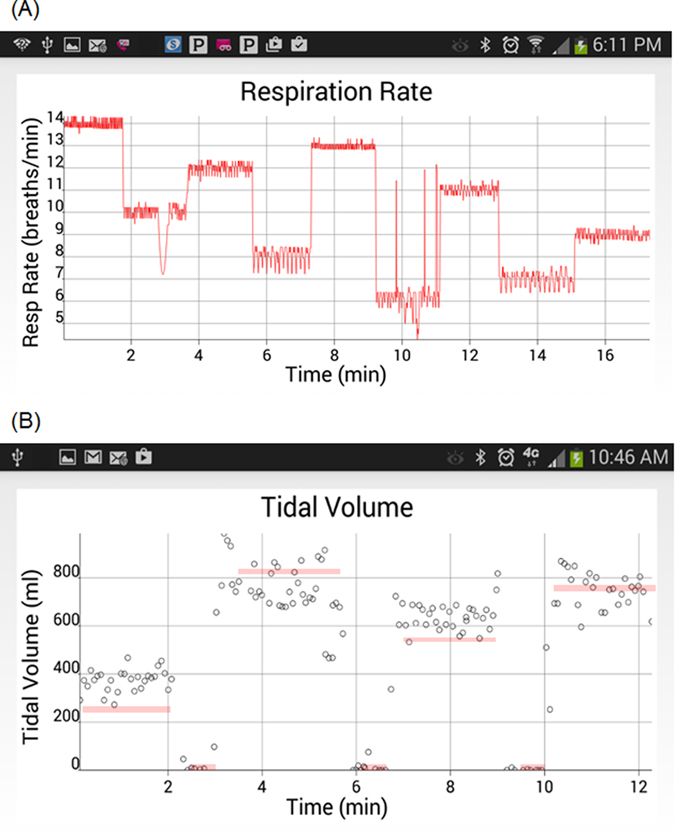
Estimation of the respiration rate (RR) and tidal volume (TV).Different RRs and TVs were obtained by adjusting the mechanical ventilator and using the reading in its display as the gold-standard. (A) The respiration rate was randomly changed from 14 to 10 to 12 to 8 to 13 to 6 to 11 to 7 to 9 breaths/min, while the TV was 500 ml and the heart rate was ~122 bpm. (B) The TV was changed from 250 to 0 to 820 to 0 to 540 to 0 to 760 ml (marked by the thick red lines), while the RR was 14 breaths/min.